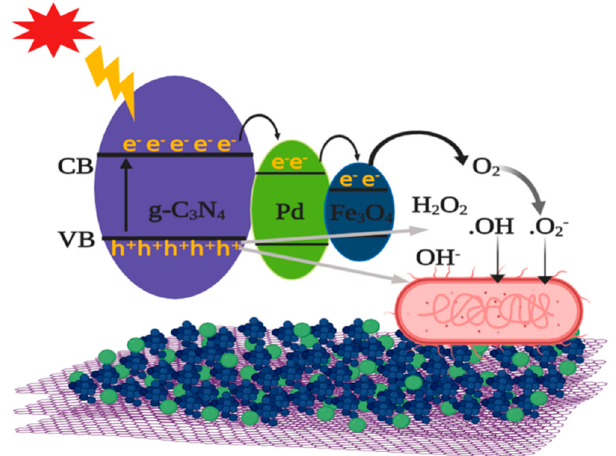
Figure 6. Schematic illustration of photocatalytic antibacterial mechanism of Fe 3 O 4 / Pd / mpg-C 3 N 4 nanocomposites under solar light illumination.